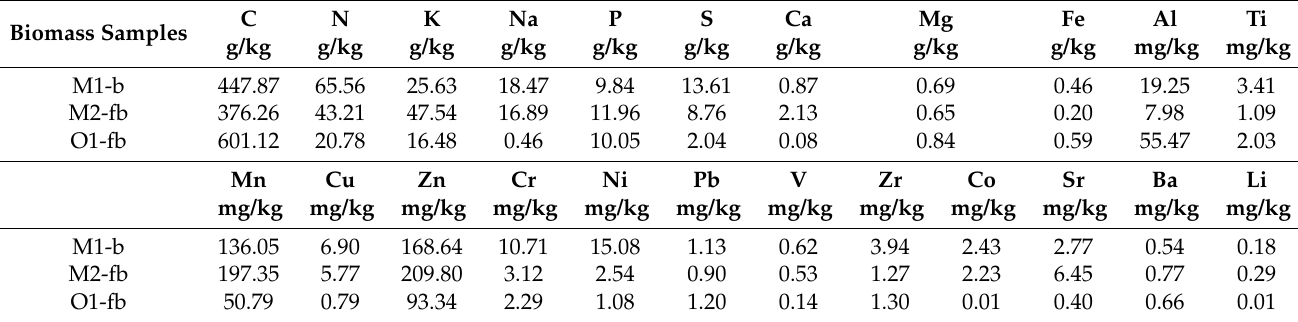
Table 4. Elemental composition of dry biomass of Y. lipolytica KKP 379 from M1-b, M2-fb and O1- fb